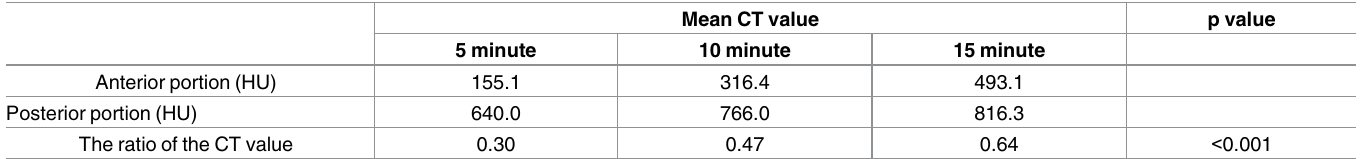
Table 4. Homogeneity of the urinary